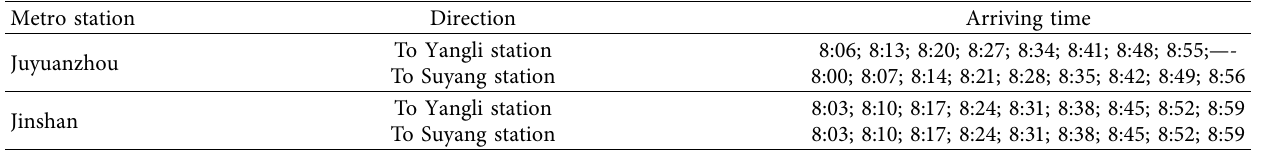
Table 4: Metro arrival timetable.